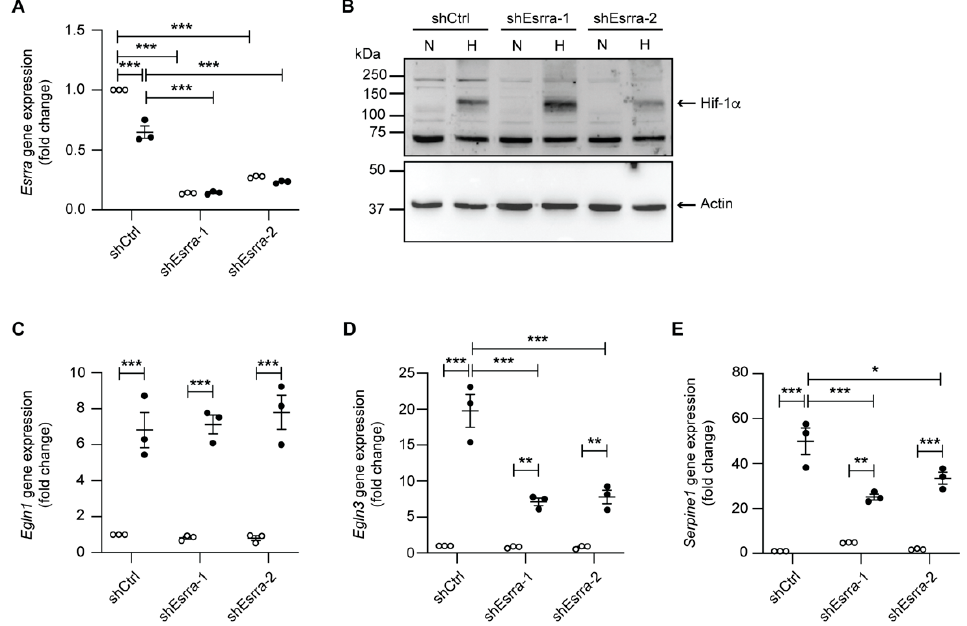
Figure 5. shRNA-mediated knockdown of ESRRA leads to reduced Egln3 and Serpine1 levels inde- pendently of Hif-1 α . ( A ) Relative mRNA expression levels of Esrra in mCCD cl1 cells transduced with control shRNA (shCtrl) and two different shRNAs targeting Esrra (shEsrra-1 and shEsrra-2) in normoxia (N) or following 24 h of hypoxia (H) ( n = 3 per condition). ( B ) Representative immunoblot of Hif-1 α in mCCD cl1 cells transduced with control shRNA (shCtrl) and two different shRNAs targeting Esrra (shEsrra-1 and shEsrra-2) in normoxia (N) or following 24 h of hypoxia (H). β -actin was used as a loading control. Relative mRNA expression levels of ( C ) Egln1 , ( D ) Egln3, and ( E ) Serpine1 in mCCD cl1 cells transduced with control shRNA (shCtrl) and two different shRNAs targeting Esrra (shEsrra-1 and shEsrra-2) in normoxia (N) or following 24 h of hypoxia (H) ( n = 3 per condition). * p < 0.05, ** p < 0.01, *** p < 0.001.